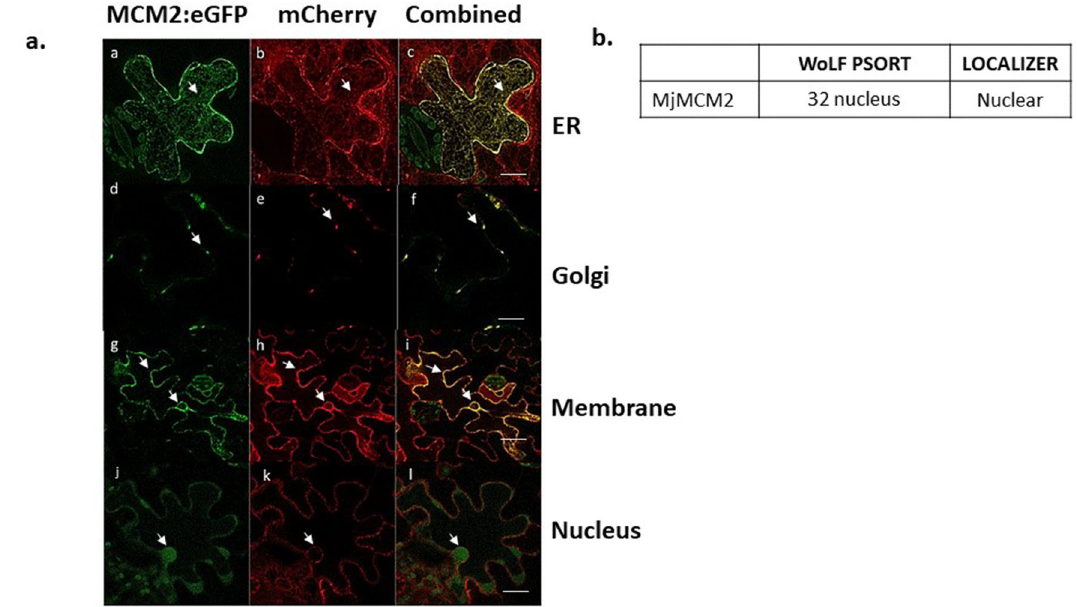
Figure 4. Subcellular localization of MjMCM2 tagged with eGFP in N. benthamiana leaves and apparent co-localization with endoplasmic reticulum, Golgi and plasma membrane. Organelle markers: mCherry– endoplasmic reticulum (ER-Rb; 35S::mCherry-HDEL), mCherry–Golgi (GmMan1-RFP) and mCherry– cytoplasmic membrane (aquaporin PIP2A:RFP). Samples were analyzed with HyD (hybrid) detectors ranging from 500 to 530 and 580 to 650 nm, respectively. Leaves were infiltrated with a 1:1 mixture of A. tumefaciens GV3010 containing ( a – c ) MjMCM2–eGFP (green) or ER-Rb (red); ( d – f ) MjMCM2–eGFP or Golgi-Rb(GmMan1-RFP) (red); ( g – i ) MjMCM2 – eGFP or membrane-Rb(aquaporin PIP2A:RFP) (red); ( j – l ) MjMCM2 – eGFP or membrane-Rb(aquaporin PIP2A:RFP) (red); ( a , d , g , j ) Images acquired with BA505–525 filter for GFP. ( b , e , h , k ) Images acquired with filter BA560IF for RFP. ( c , f , i , l ) Sequential acquisition and fusion of images acquired with both filters, overlap of GFP and RFP signals displayed in yellow. Scale bars: ( c ) 10 µm; ( f ) 5 µm; ( i ) 20 µm; ( l ) 10 µm. ( b ) Subcellular location results of MjMCM2 as predicted using WoLF PSORT (https:// www. gensc ript. com/ wolf- psort. html; and LOCALIZER (http:// local izer. csiro.